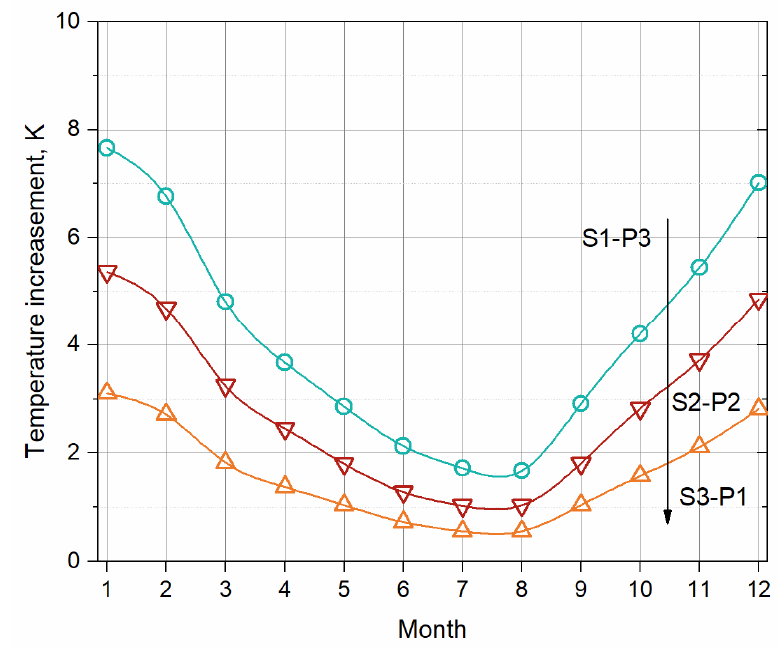
Figure 6. Temperature difference between the inlet and outlet of the wet section of S3-P1, S2-P2 and S1-P3.